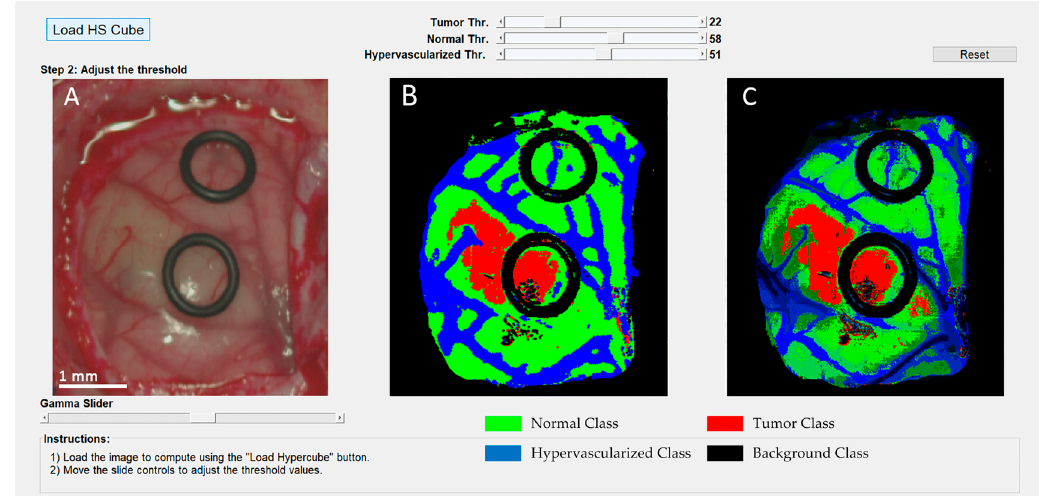
Figure 10. Surgical aid visualization user interface with manual adjustable threshold values. ( A ) Synthetic RGB image generated from the hyperspectral imaging (HSI) cube. ( B ) 1D-DNN classification map generated with the established threshold. ( C ) Density map generated with the new classification map.